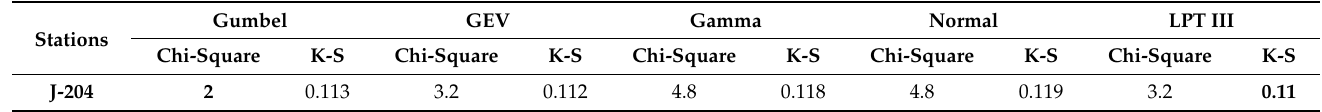
Table 3. Summary of the best-fit distribution of stations.